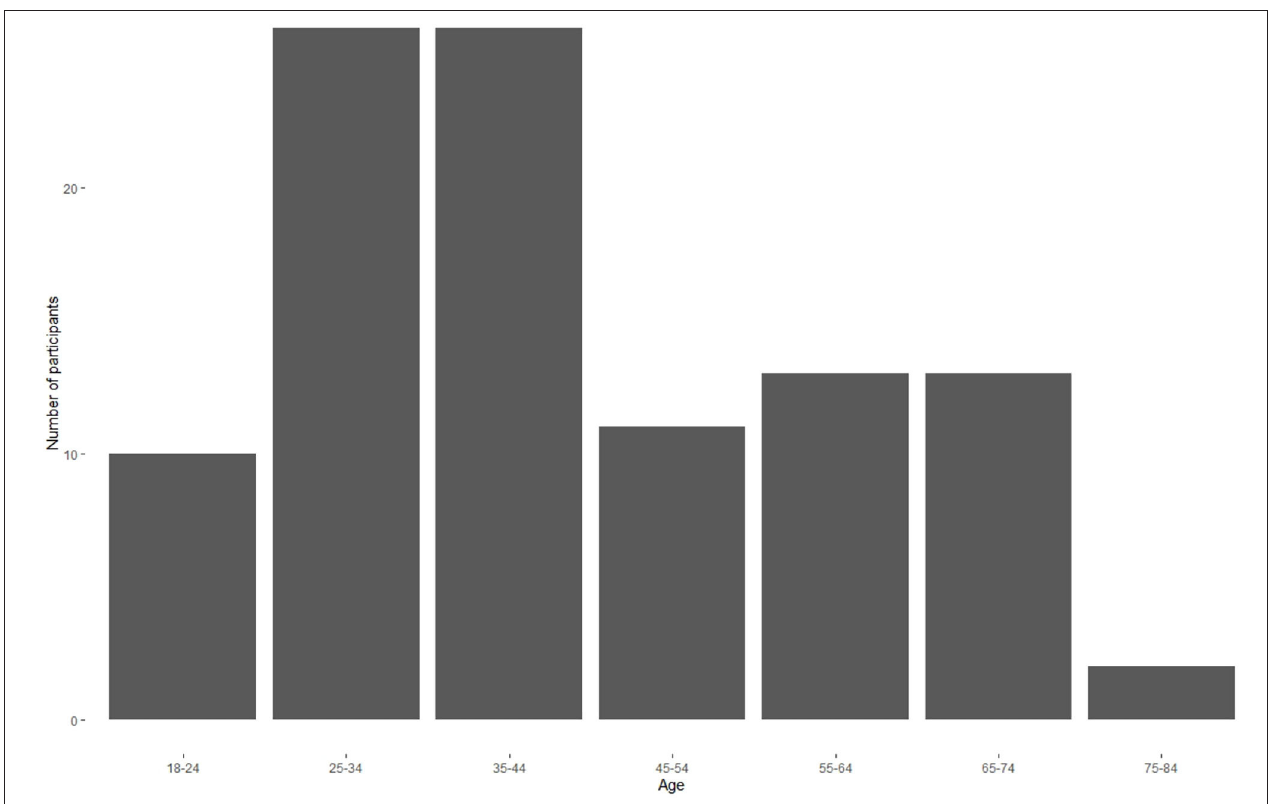
FIGURE 1 | Histogram of participant